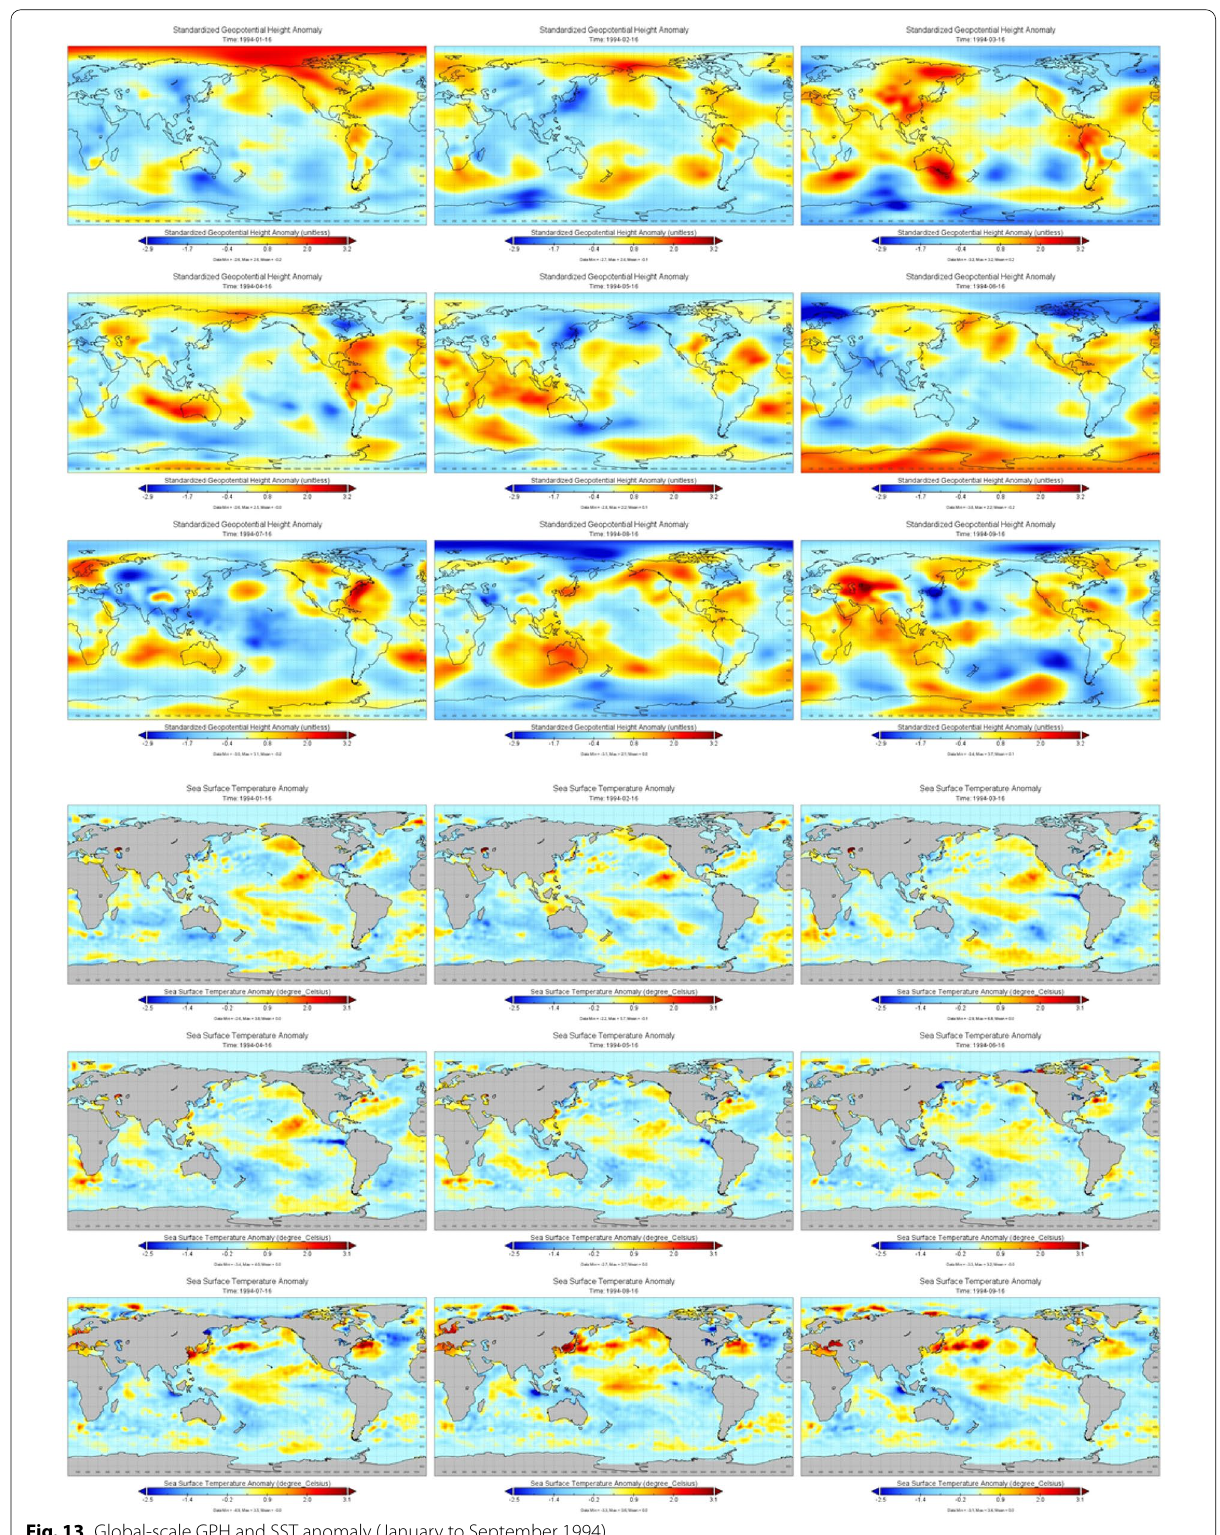
Fig. 13 Global-scale GPH and SST anomaly (January to September